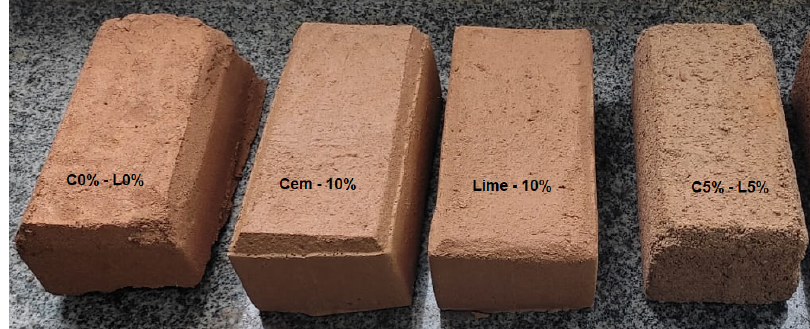
Figure 4. Adobe blocks used in the research containing manure.